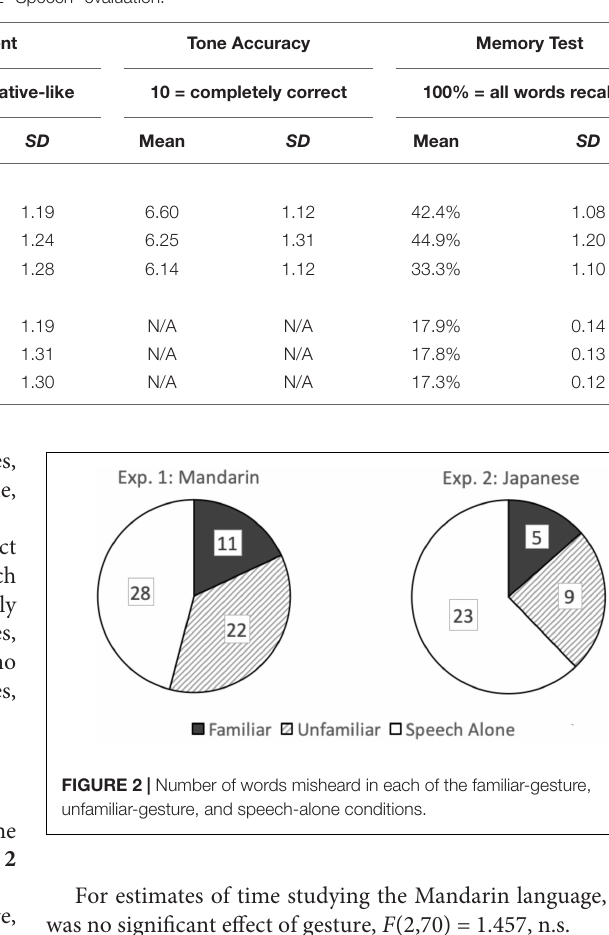
For estimates of time studying the Mandarin language, there was no significant effect of gesture, F (2,70) = 1.457,